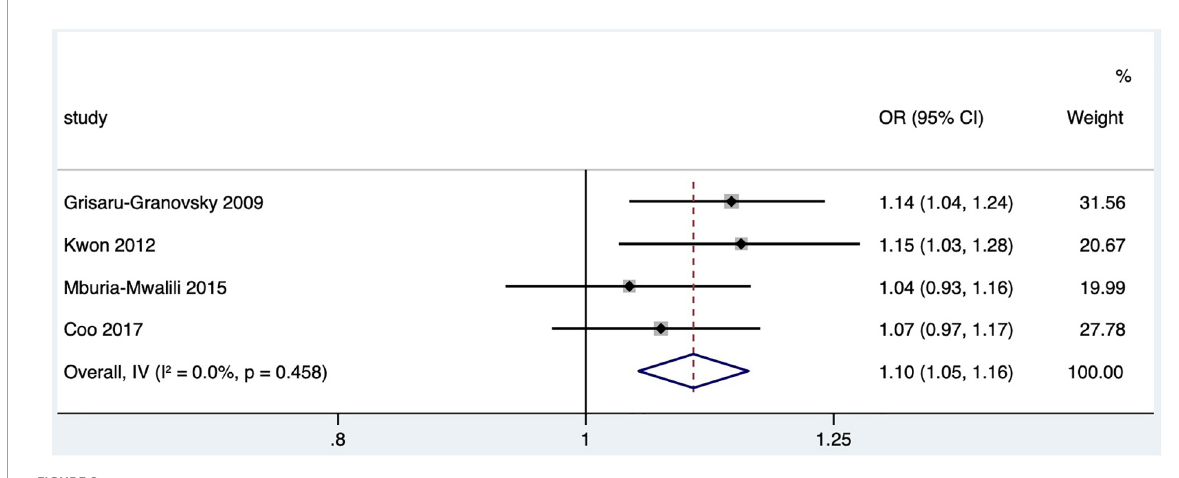
FIGURE8 Meta-analysis forest map of the influence of short IPI on congenital